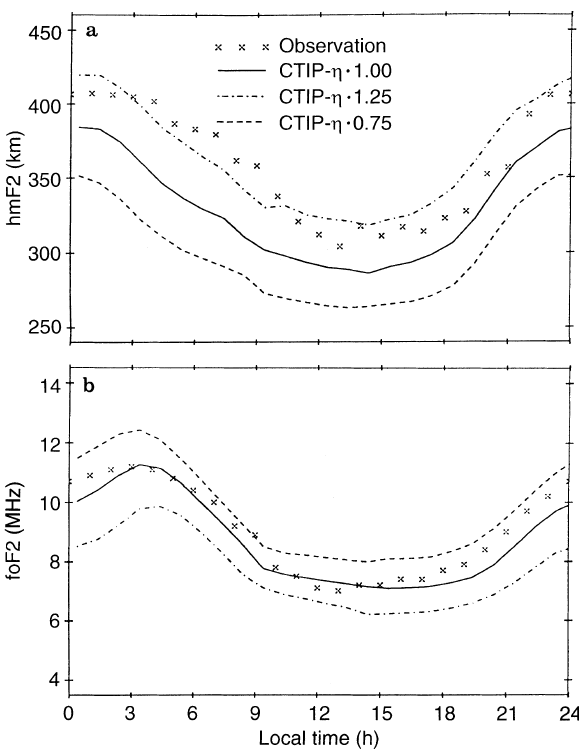
Fig. 9a,b. The sensitivity of a hmF2 and b f oF2, over Argentine Islands, to changes in the magnitude of thermospheric heating efficiency